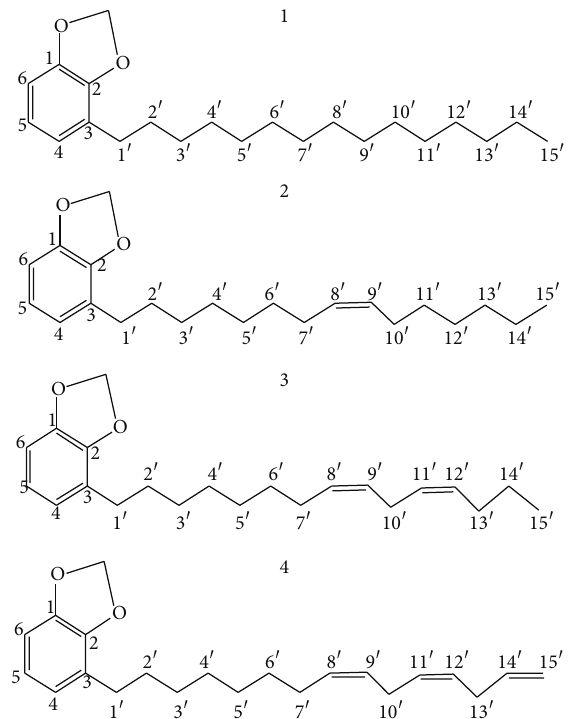
Figure 4: Structures of urushiol methylene acetal monomers (compounds 1, 2, 3, and